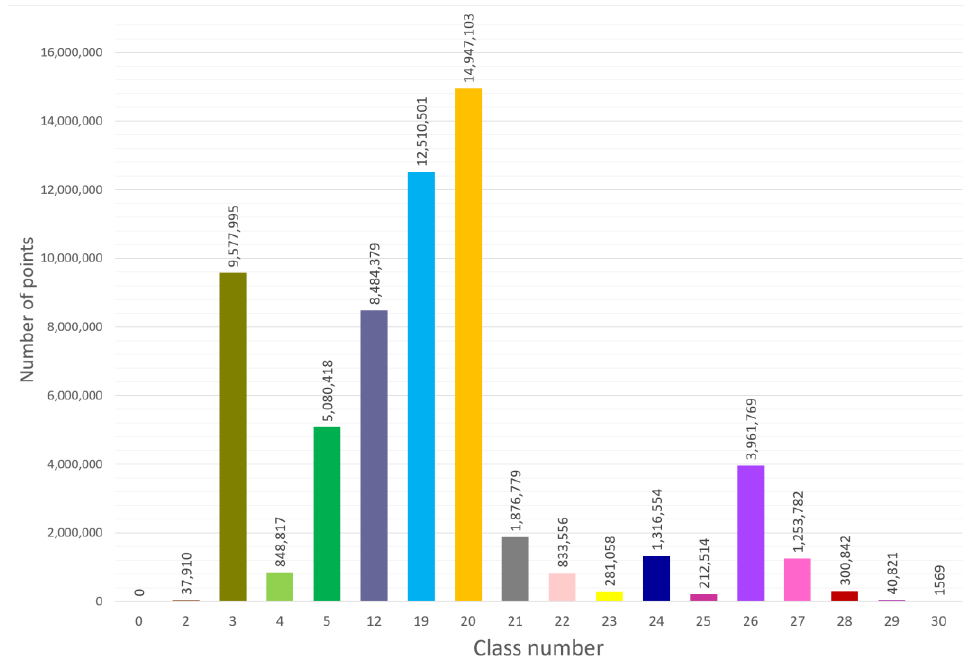
Figure 6. The distribution of different semantic classes in our CRBeDaSet. Note that a small number of points are annotated as class 30 due to only having one chimney. Additionally, note that authors do not divide the dataset into train and test parts. Because of that, users may decide which objects are needed (delete not necessary objects) for the research and then cut parts of the object for valida- tion and test purposes.